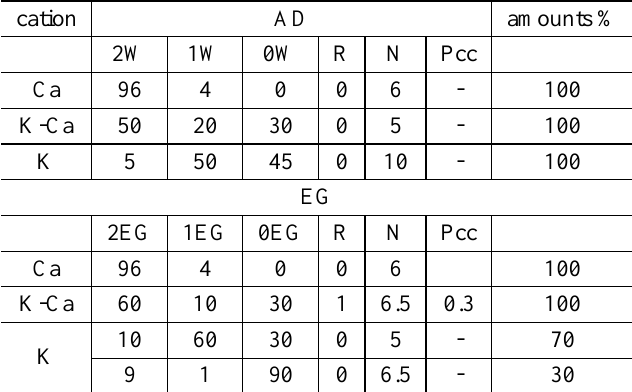
Composition of the two and three component mixed-layer minerals for Ca-, K- and K-Ca-saturated samples, as determined by XRD pattern